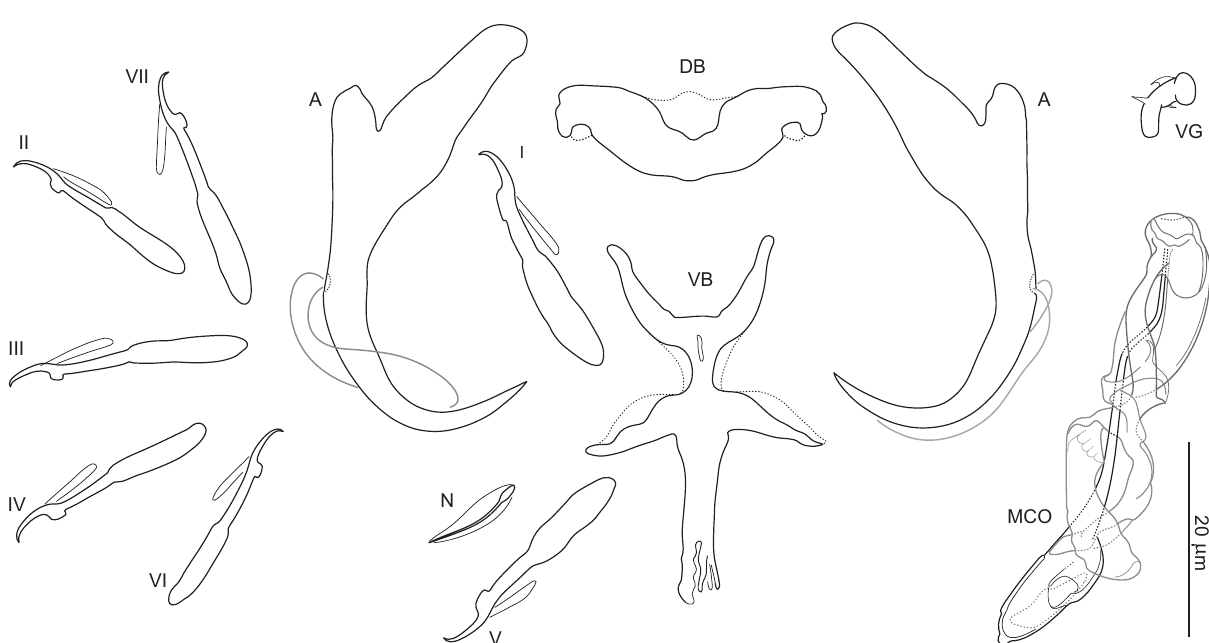
Figure 5. Sclerotized structures of Dactylogyrus romuli n. sp. ex Luciobarbus albanicus . A, anchor; DB, dorsal bar; VB, ventral bar; N, needle; I – VII, hooks; VG, vagina; MCO, male copulatory